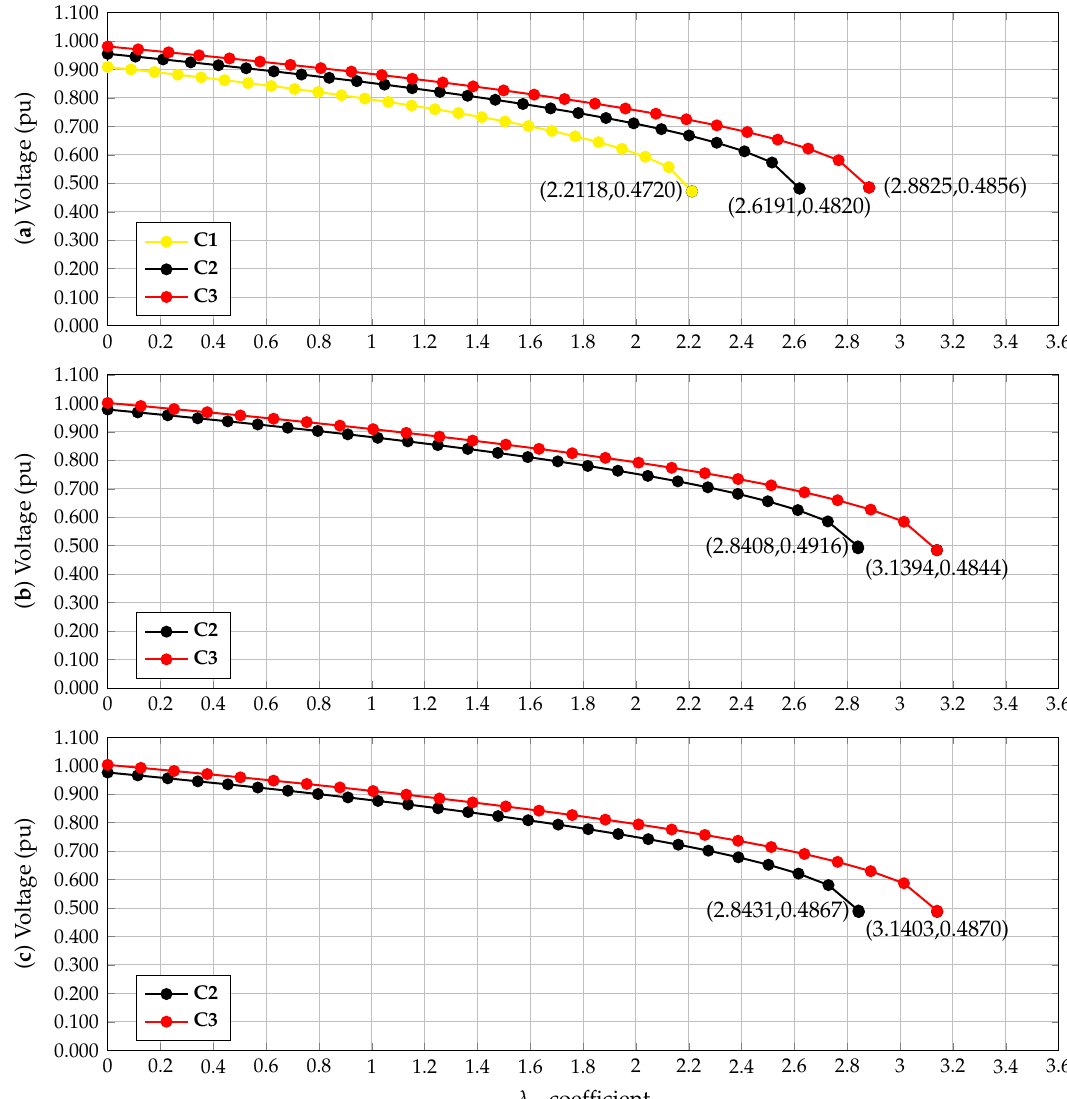
Figure 8. Voltage performance at node 65: ( a ) benchmark case and C2 and C3 with one dis- persed generator, ( b ) C2 and C3 with two dispersed generators, and ( c ) C2 and C3 with three dispersed